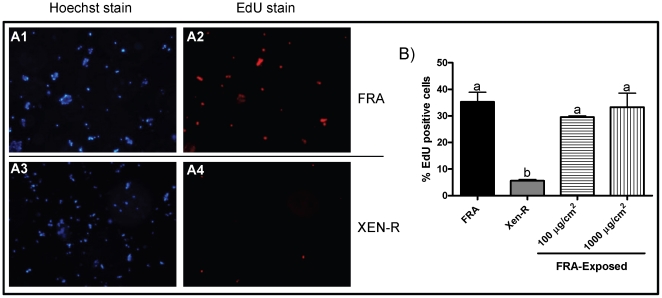
Midgut proliferation in FRA and Xen-R larvae.Hoechst (nuclear DNA) and EdU (DNA synthesis) staining of dissociated cells from last instar larvae midguts from the FRA (A1 and A2) and Xen-R (A3 and A4) colonies. Larvae were injected with EdU reagent and 5 hours post injection, midguts were dissected, cells dissociated and stained for Hoechst and EdU. Percentage of EdU positive cells in FRA, Xen-R, and FRA insects previously exposed to Xentari™ (B). Different letter denote statistically different values (t-test, p-value <0.05).